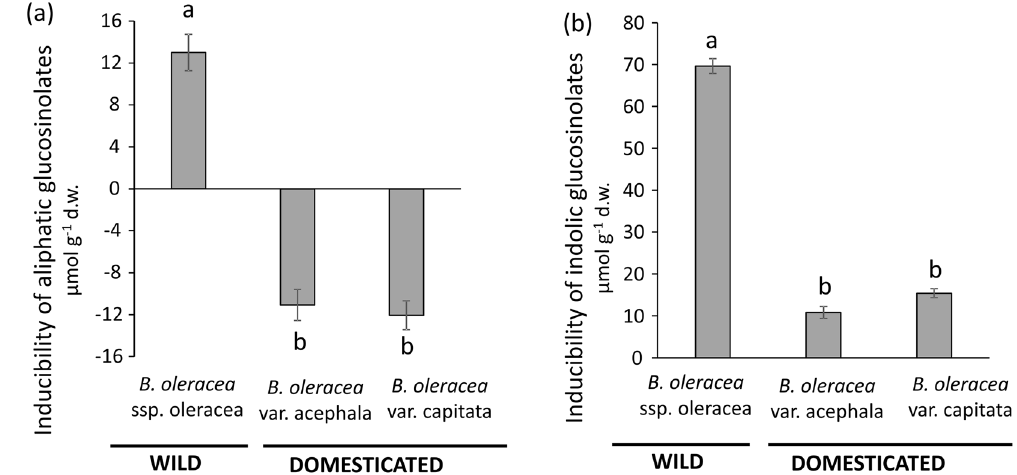
Figure 3. Effects of plant domestication on the inducibility of leaf chemical defences. Inducibility (i.e., the ability of plants to increase their defence levels in response to herbivory or some other type of stressor) of (a) aliphatic and (b) indolic glucosinolates in leaves of wild cabbage ( Brassica oleracea ssp. oleracea) and two domesticated varieties of this species ( B . oleracea var. acephala and B . oleracea var. capitata). Plants were induced by Mamestra brassicae larvae which fed on the plants for one week. Bars are least square means ± s.e.m. (N = 60 plants per plant line). Different letters indicate significant ( P < 0.05) differences between plant lines (see Table 2 for statistics). d.w. = dry weight.